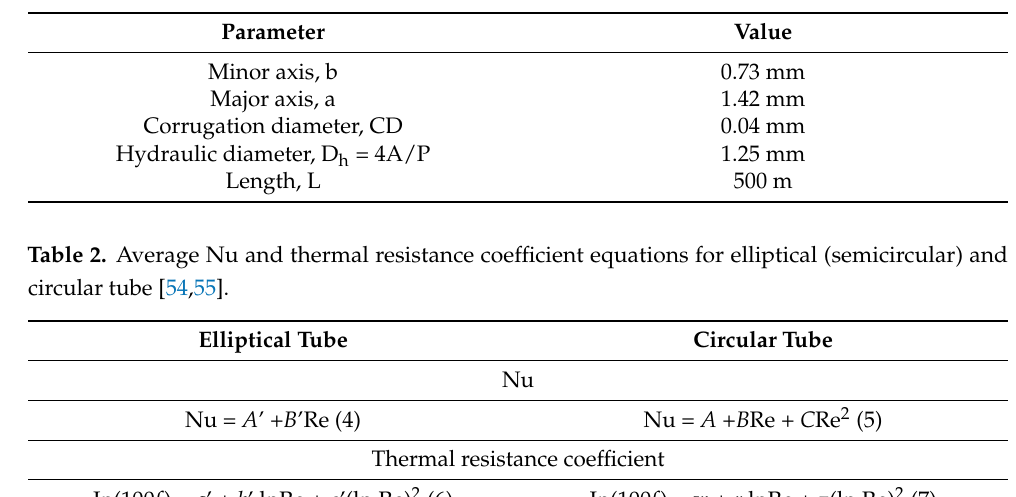
Table 1. Geometrical parameters.